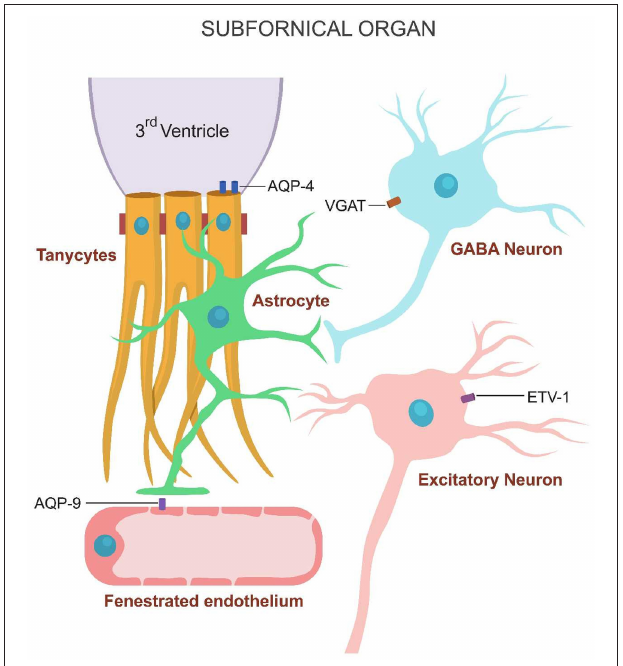
FIGURE 2 | Water channels expressed on the SFO cells. Inhibitory GABAergic neurons express VGAT, astrocytes AQP-9 and tanycytes AQP-4.